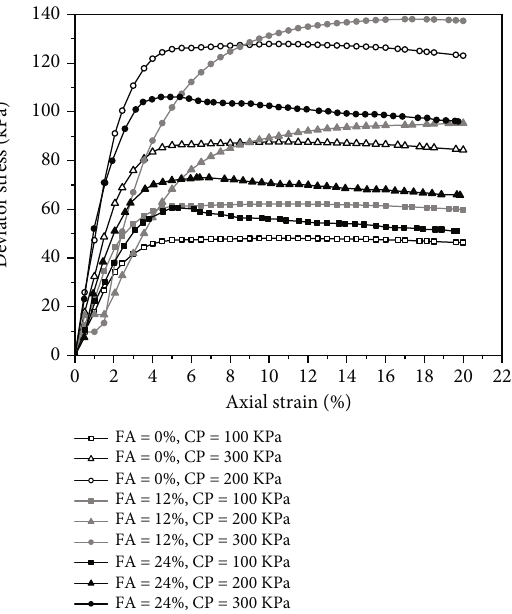
Figure 11: Stress-strain curves ( FT = 30 , L = 6 % ).